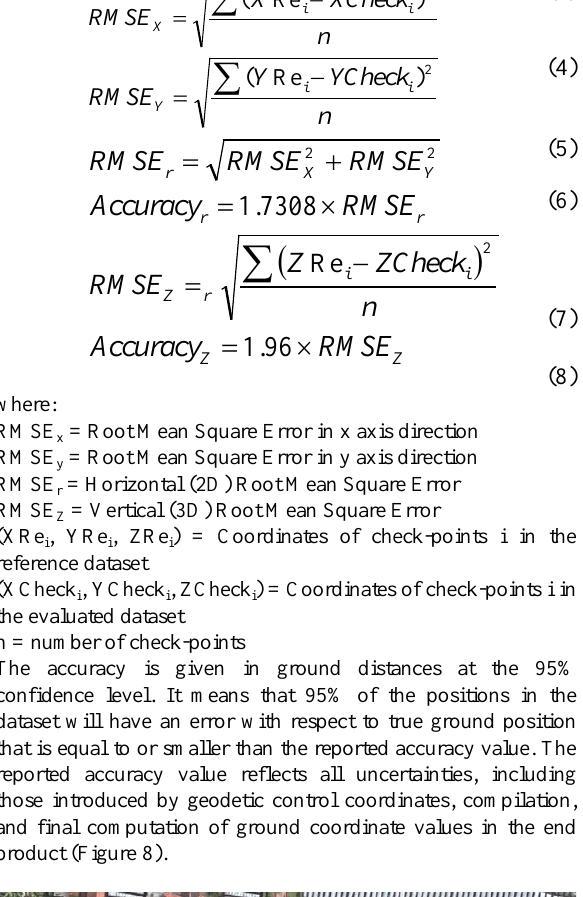
Based on height deviation from road network features